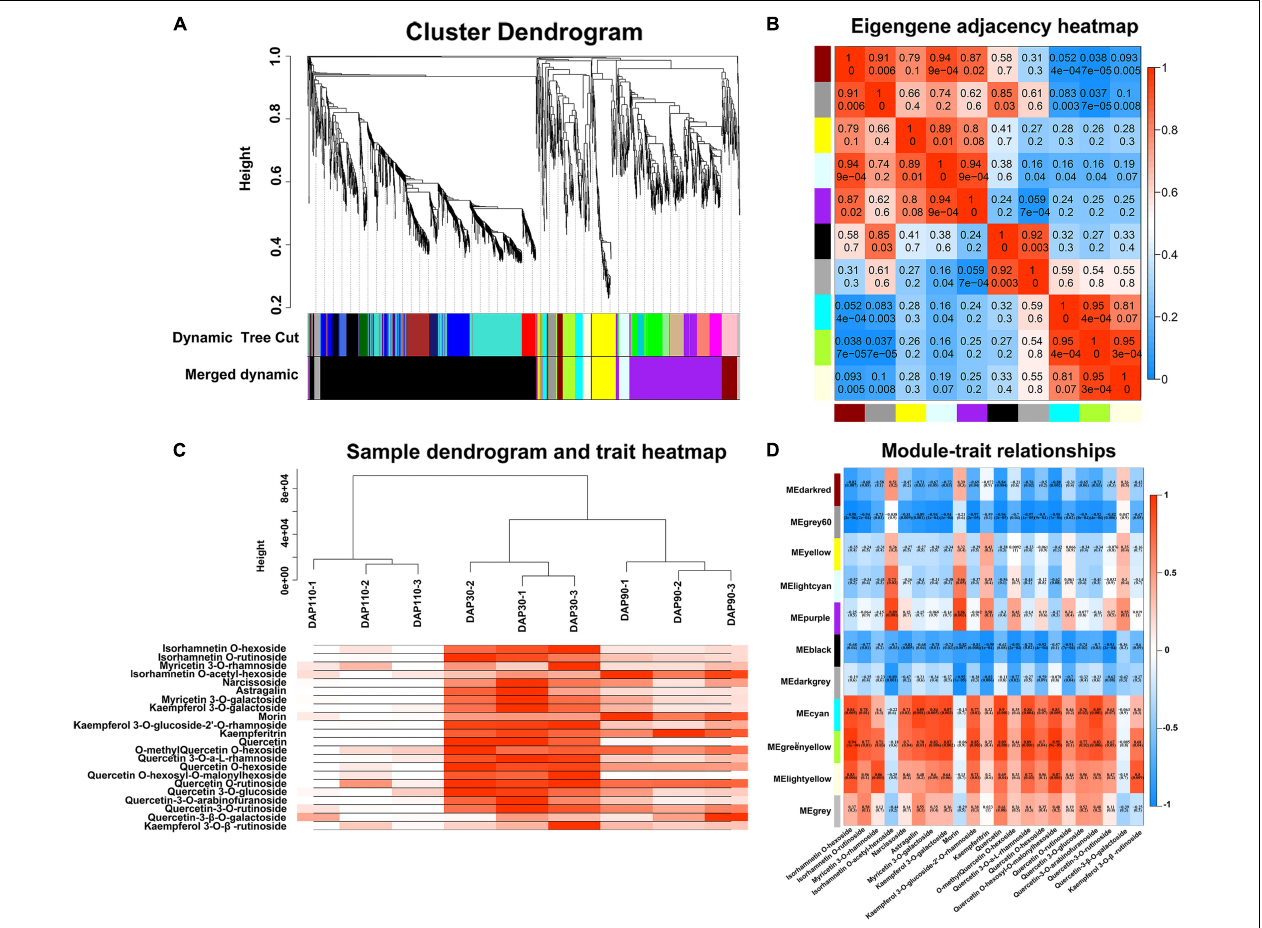
FIGURE 3 | Weighted gene co-expression network analysis of differentially expressed genes. (A) Cluster dendrogram. (B) Eigengene adjacency heatmap. (C) Sample dendrogram and trait heatmap. (D) Heatmap of module and trait